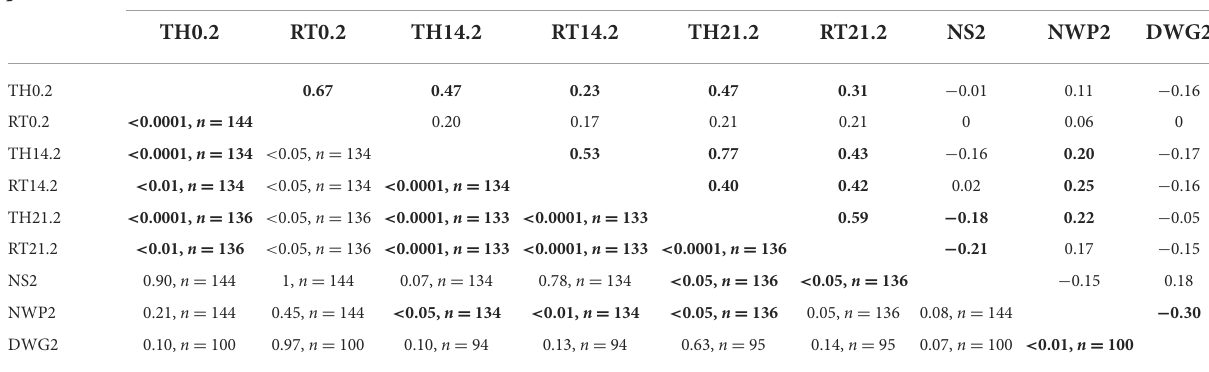
TABLE 4 Pearson correlation coefficient between thermographic skin temperature, rectal temperature, stillborn piglets, number of weaned piglets and daily weight gain of suckling piglets of second parity sows. p -value ( N )